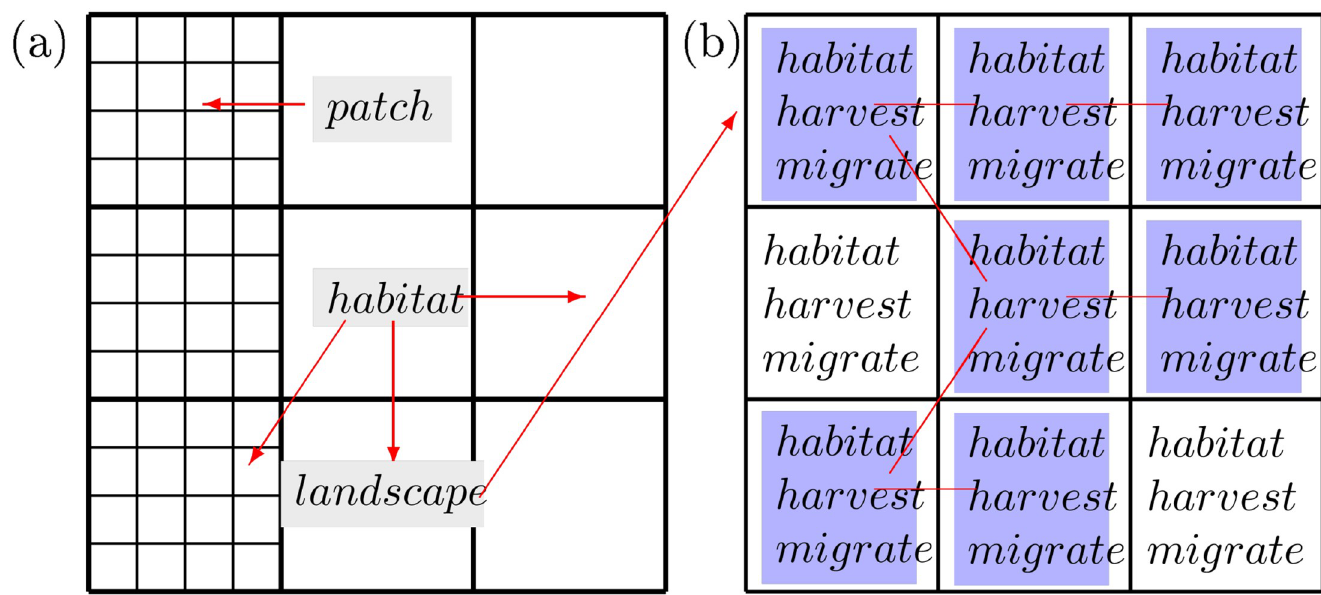
Fig 1. Conceptual landscapes. (a) Hierarchy of foraging decisions in space [20]. The far left column represents patch choices. Patch choices occur daily or weekly as foragers radiate out from base camps to access the smallest patch blocks. Habitat choices occur monthly-to-annually as foragers choose between the moderate sized blocks, and, at the landscape scale, foragers make decisions about their home-ranges a few times over decades by choosing between blocks of landscape (e.g., pages 380–383 in [21]). (b) Habitats that foragers may use. Foragers must choose where to reside (habitat), how much time to spend in a given habitat (harvest) and which set of habitats to use (migrate). These decisions interact with each other by affecting resources and the decisions of other foragers. The set of blue habitats comprise a forager’s “realized territory.” We simplify our model by studying a two habitat